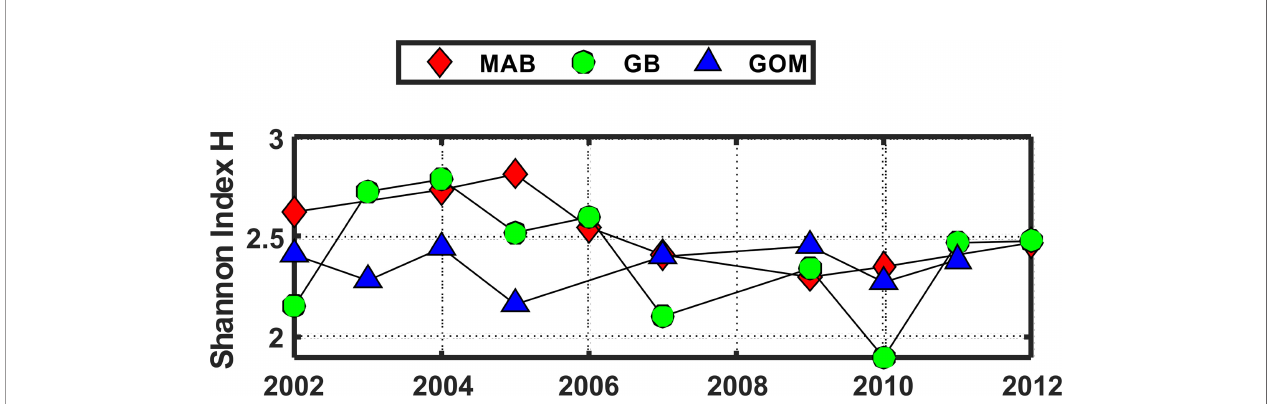
FIGURE 9 | Shannon Diversity Index (H) for the three regions based on COI sequence numbers for 23 abundant species with total sequence numbers >1000. See Table 2 for list of species. Values of the Shannon Index (H) shown here were signi fi cantly correlated with Simpson Index values (r = 0.953, p = 6.657 e -14 ). Regions are: Mid-Atlantic Bight (MAB), Georges Bank (GB), Gulf of Maine